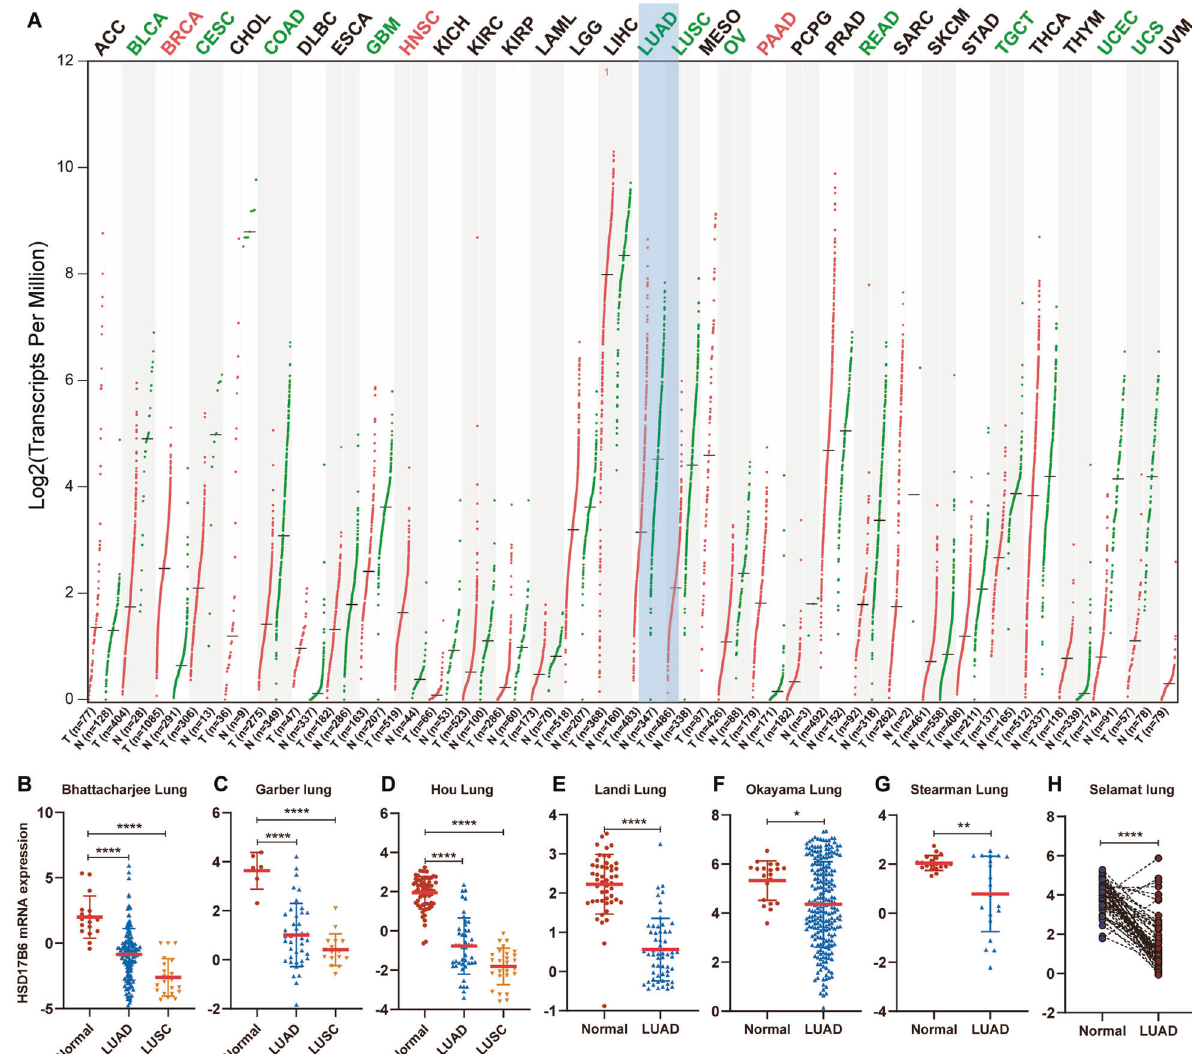
Fig. 1 Differential mRNA expression of HSD17B6 between tumors and corresponding non-cancerous tissues. A Comparison of HSD17B6 mRNA levels between tumors and normal samples in 32 types of cancers in TCGA using the GEPIA web tool (red lines indicate tumor samples; green lines indicate non-cancerous samples). B – H Comparison of HSD17B6 mRNA expression among LUAD, LUSC, and adjacent non- cancerous tissues in 7 lung cancer datasets from Oncomine. LUAD lung adenocarcinoma, LUSC lung squamous cell carcinoma. **** p < 0.0001, ** p < 0.01, * p <